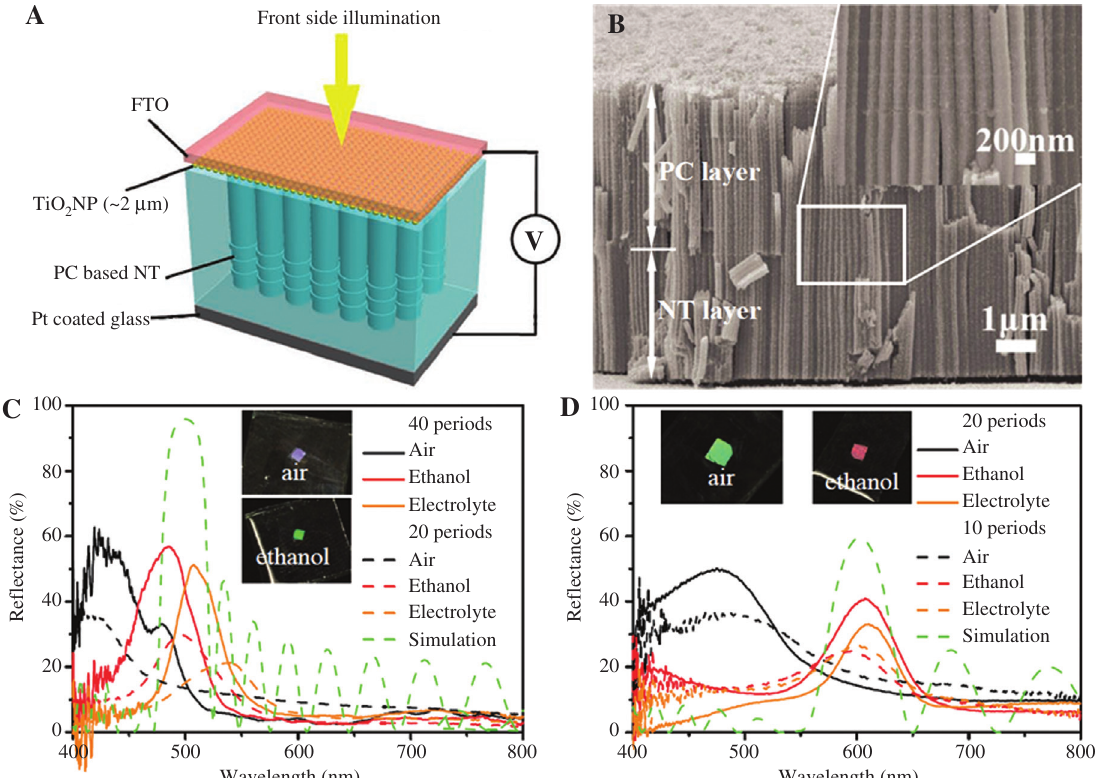
Figure 9 (A) The schematic of the solar cell device assembly. The main part of the photoanode is double-layered NTs of upper-region NT PCs with periods on tube walls and lower-region normal NTs with smooth tube walls (viewing from the light incident direction). (B) The SEM images of the NTs fabricated by a single anodization step, including one layer of PCs based on NTs and another layer of normal NTs. From the SEM image of the interface region shown in the inset, distinct variation of tube wall morphologies can be observed. (C) The reflection of the samples (period length ∼ 150 nm) with 40 or 20 periods in air, ethanol and electrolyte. The optical images in the inset show the film colors in air or ethanol. (D) The reflection of the samples (period length ∼ 190 nm) with 20 or 10 periods. Reprinted with permission from